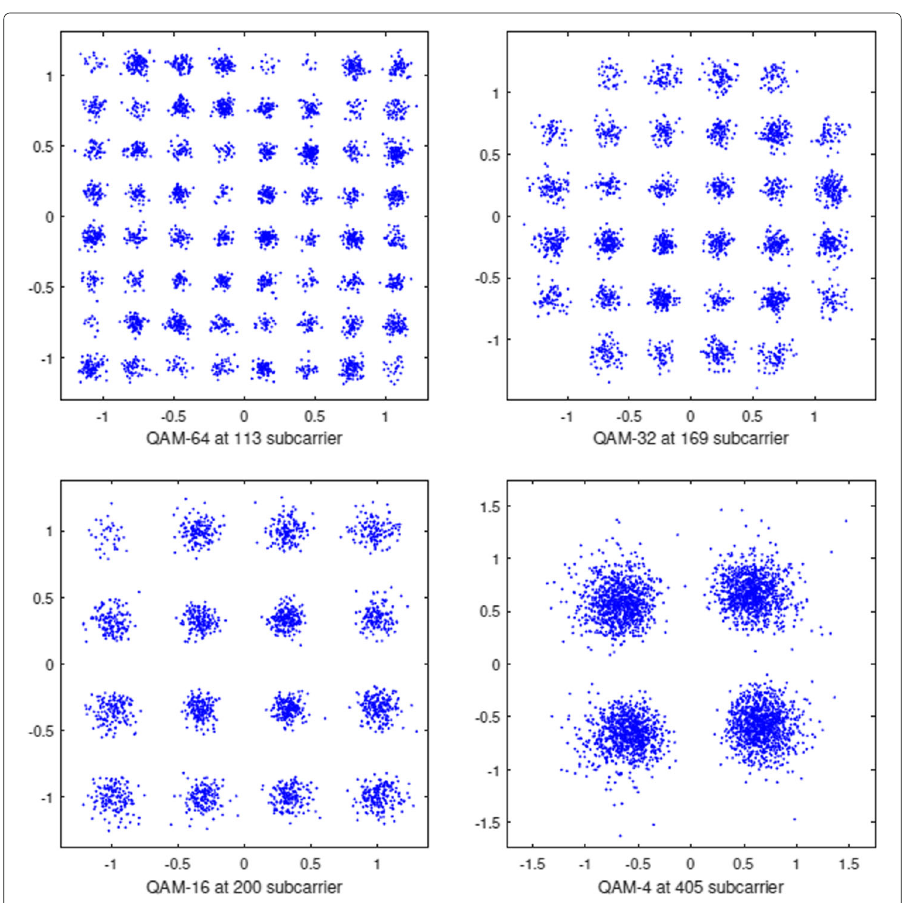
Fig. 17 Received constellation for different subcarriers. The constellation of the 113th,169th, 200th, and 405th subcarriers after equalization and